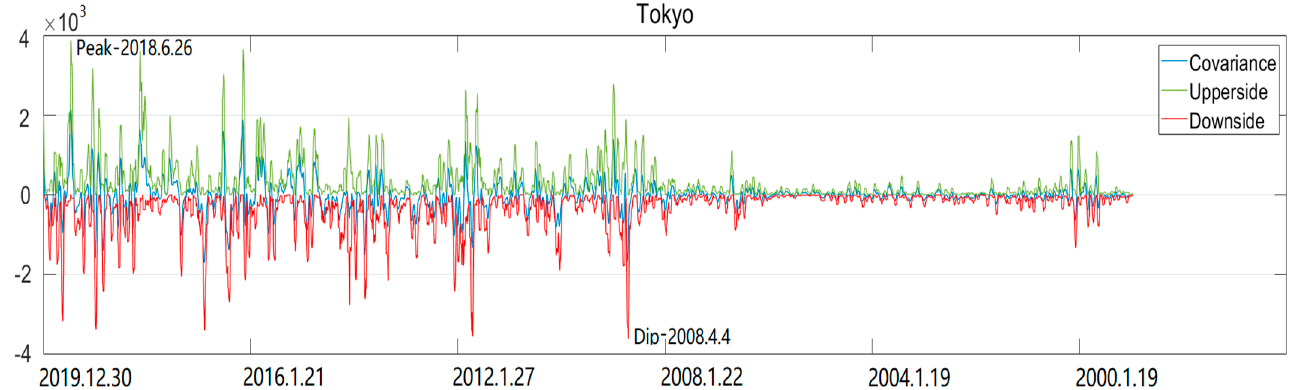
Figure 4. Bi ‐ weekly/semi ‐ covariances between gold price and stock for Tokyo Japan from the year 2019 back to 1999.